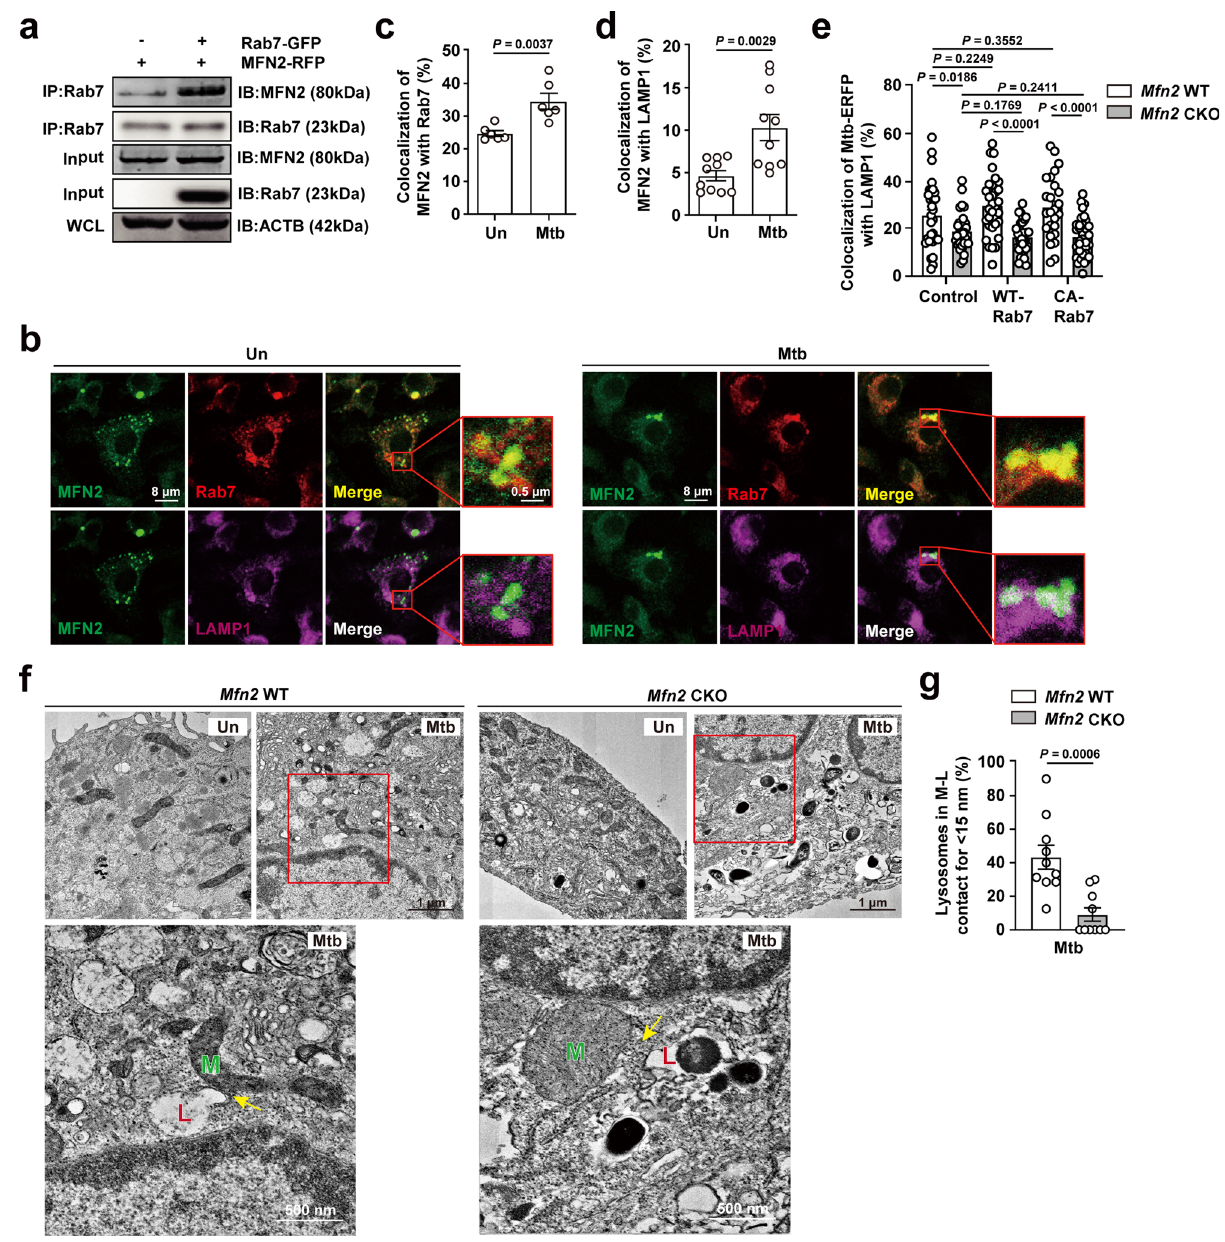
Fig. 8 MFN2 interacts with Rab7 for the activation of xenophagy. a Immunoprecipation analysis from RAW264.7 cells transfected with MFN2-RFP or Rab7-GFP. Representative immunoblots for the indicated protein expression. b – d Confocal microscopy images of BMDMs infected with Mtb (MOI 5) and stained with MFN2 (green), Rab7 (red), and LAMP1 (magenta). Representative images for MFN2 co-localization with Rab7 or LAMP1. Scale bars, 8 μ m and 0.5 μ m ( b ). c , d Quantitative data of co-localization of MFN2 and Rab7 ( c ) or LAMP1 ( d ). Fifty cells in six ( c ) or ten ( d ) fi elds were counted in each